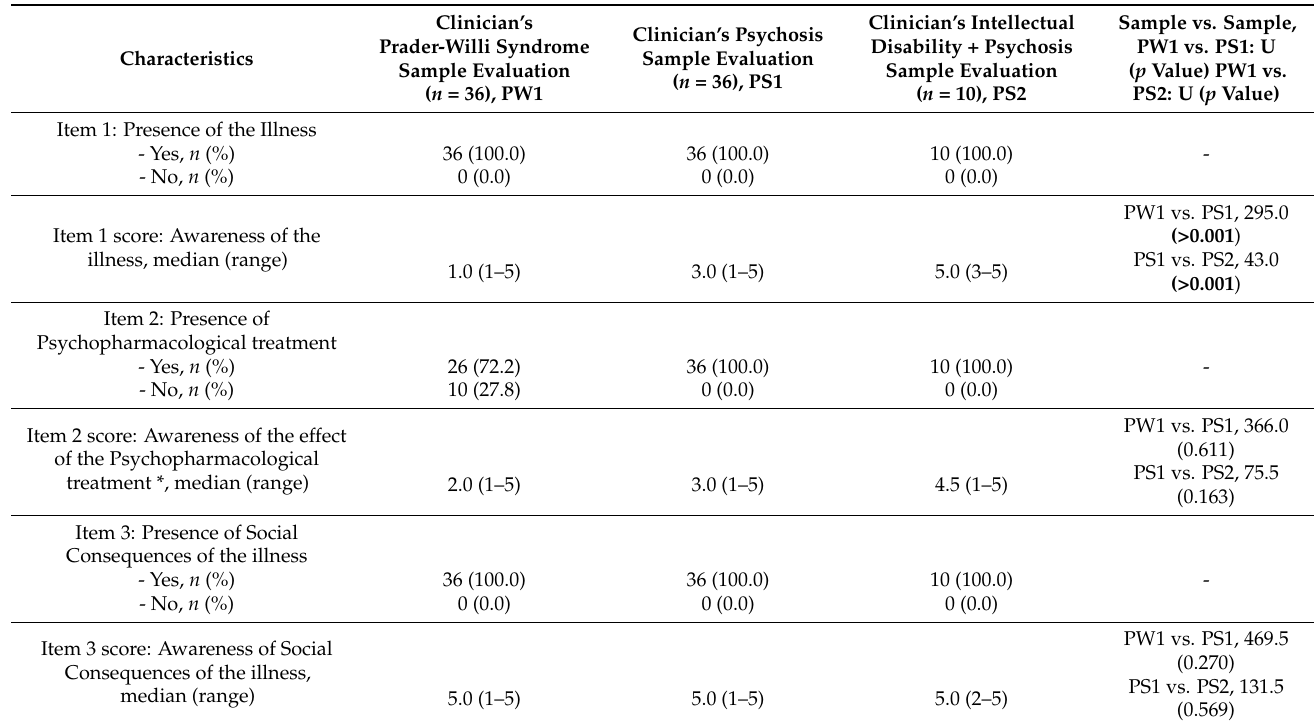
Table 3. Comparative characteristics of the samples following the adapted APW-SUD (Prader-Willi sample) or validated SUMD (psychosis